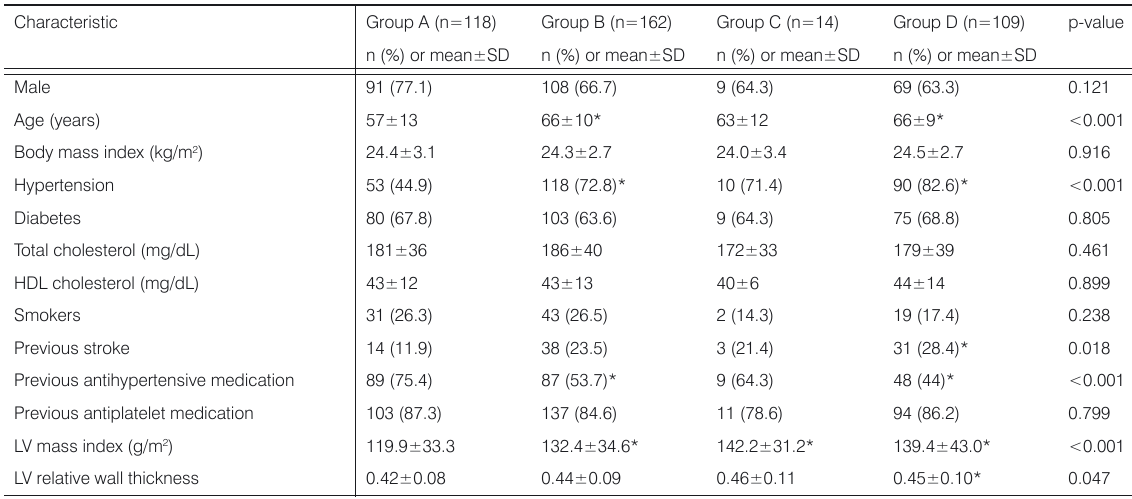
Table 6. Clinical characteristics of patients with each combination of subtypes of small-artery disease.